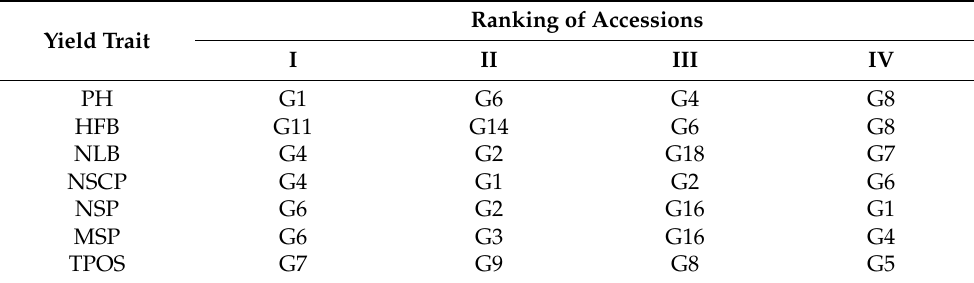
Table 6. Ranking of the 20 spring camelina accessions by their average trait means and their stability in various